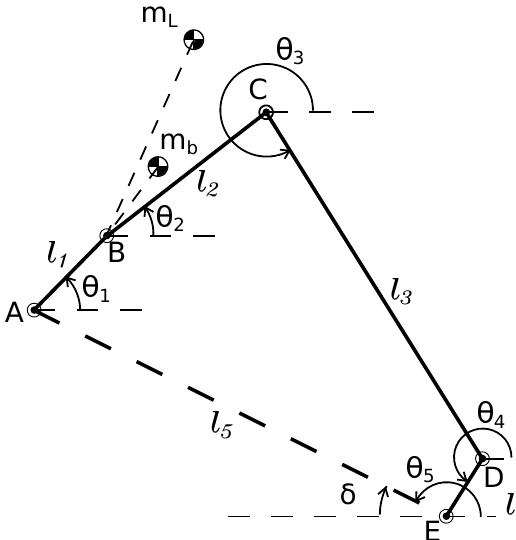
Figure 6. Kinematic model of the robot. Position, Velocity and